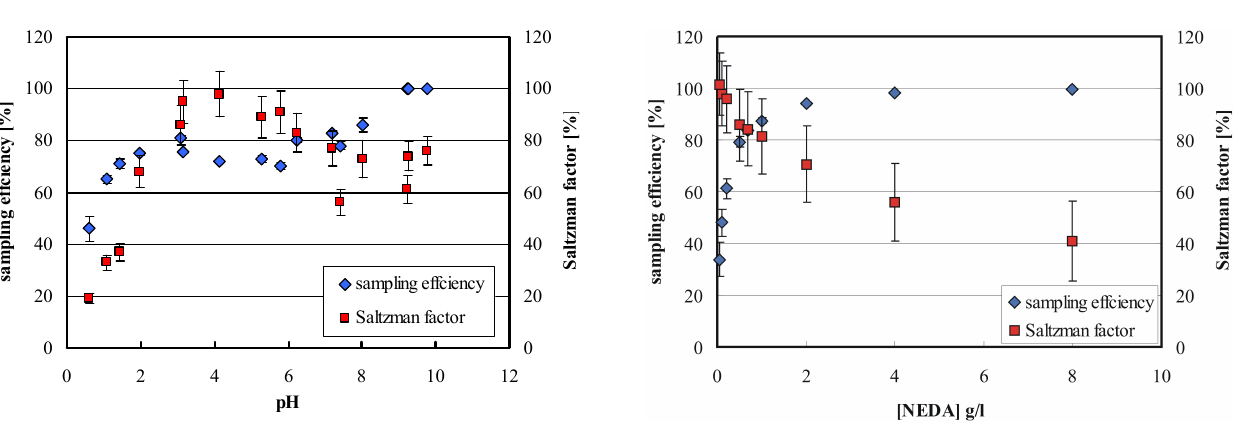
Fig. 3. Variation of the sampling efficiency and the Saltzman fac- tor with the NEDA concentration. Griess-Saltzman reagent: 7gl − 1 sulphanilamide, 84gl − 1 acetic acid, pH=3, adjusted with NH 3 . Air flow = 650mlmin − 1 , liquid flow=0.35mlmin − 1